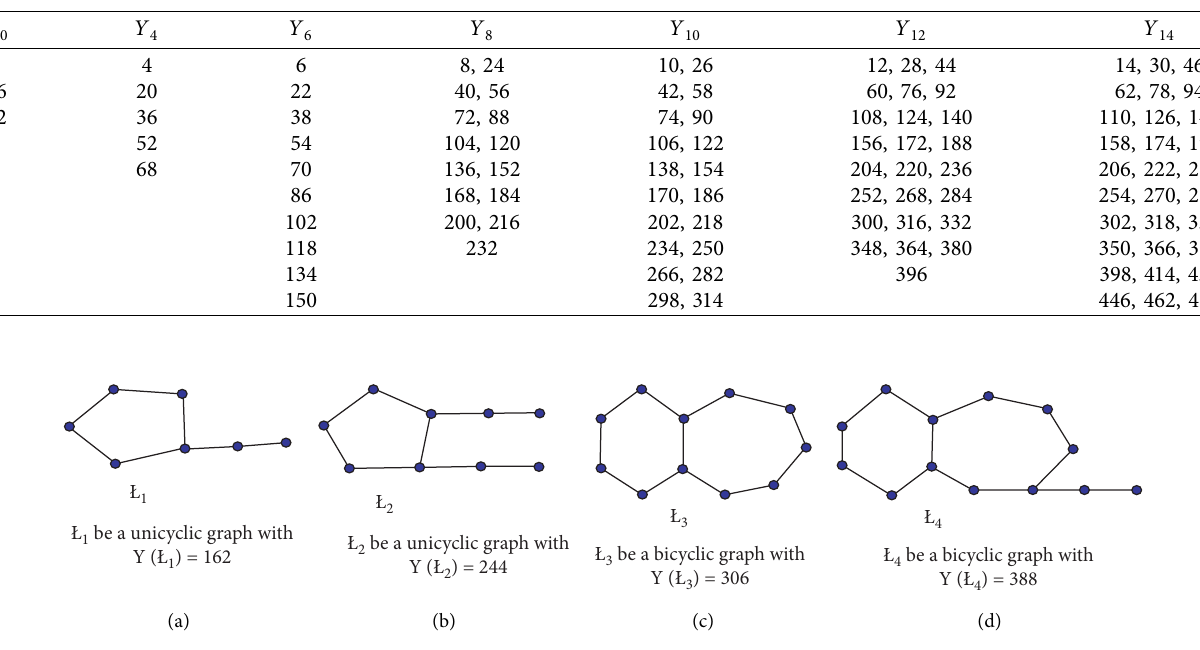
Table 1: Y -index values which do not exist.